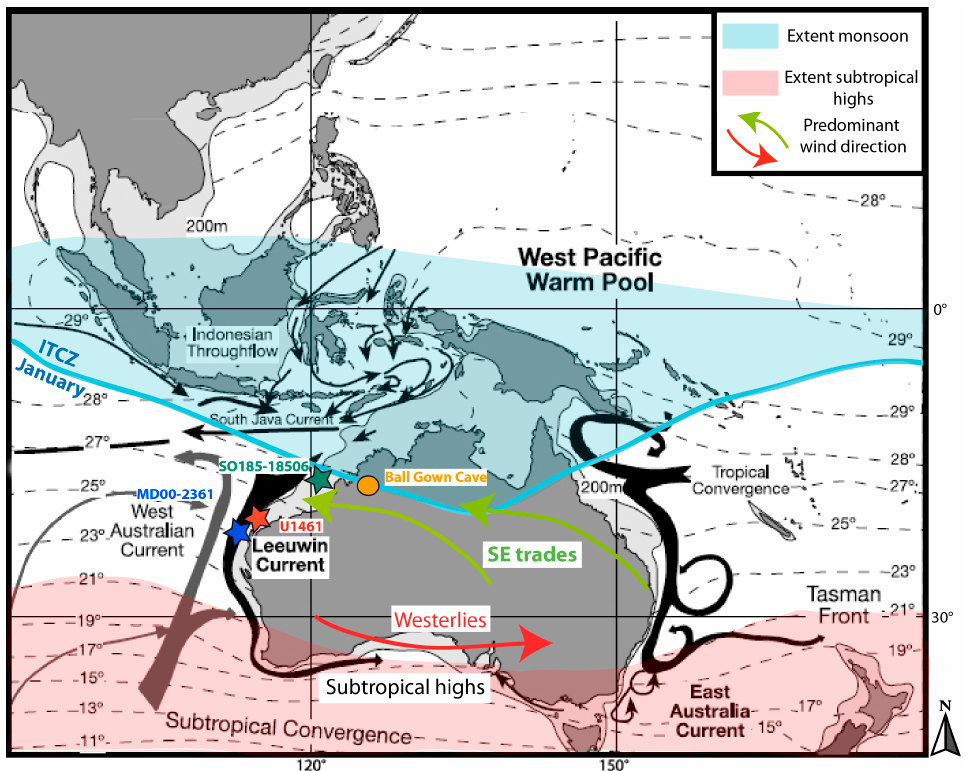
Figure 1. Oceanographic and atmospheric circulation of the Indo-Pacific. The red star indicates the location of Site U1461 (Modified from Gallagher et al., 2009 [41]). The blue star indicates the location of MD00-2361 [12]. The green star indicates the location of SO185-18506 [42]. The orange circle indicates the position of Ball Gown Cave [43] .